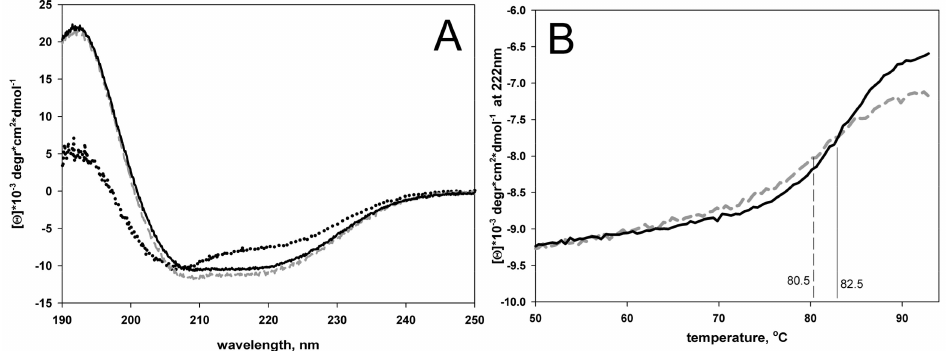
Figure 12. Circular dichroism spectra ( A ) and melting curves ( B ) of Gro190 (solid line), Gro207 (dashed line), and Gro230 (dots on figure A). The centers of the melting curves (melting temperatures) are shown by vertical lines on figure